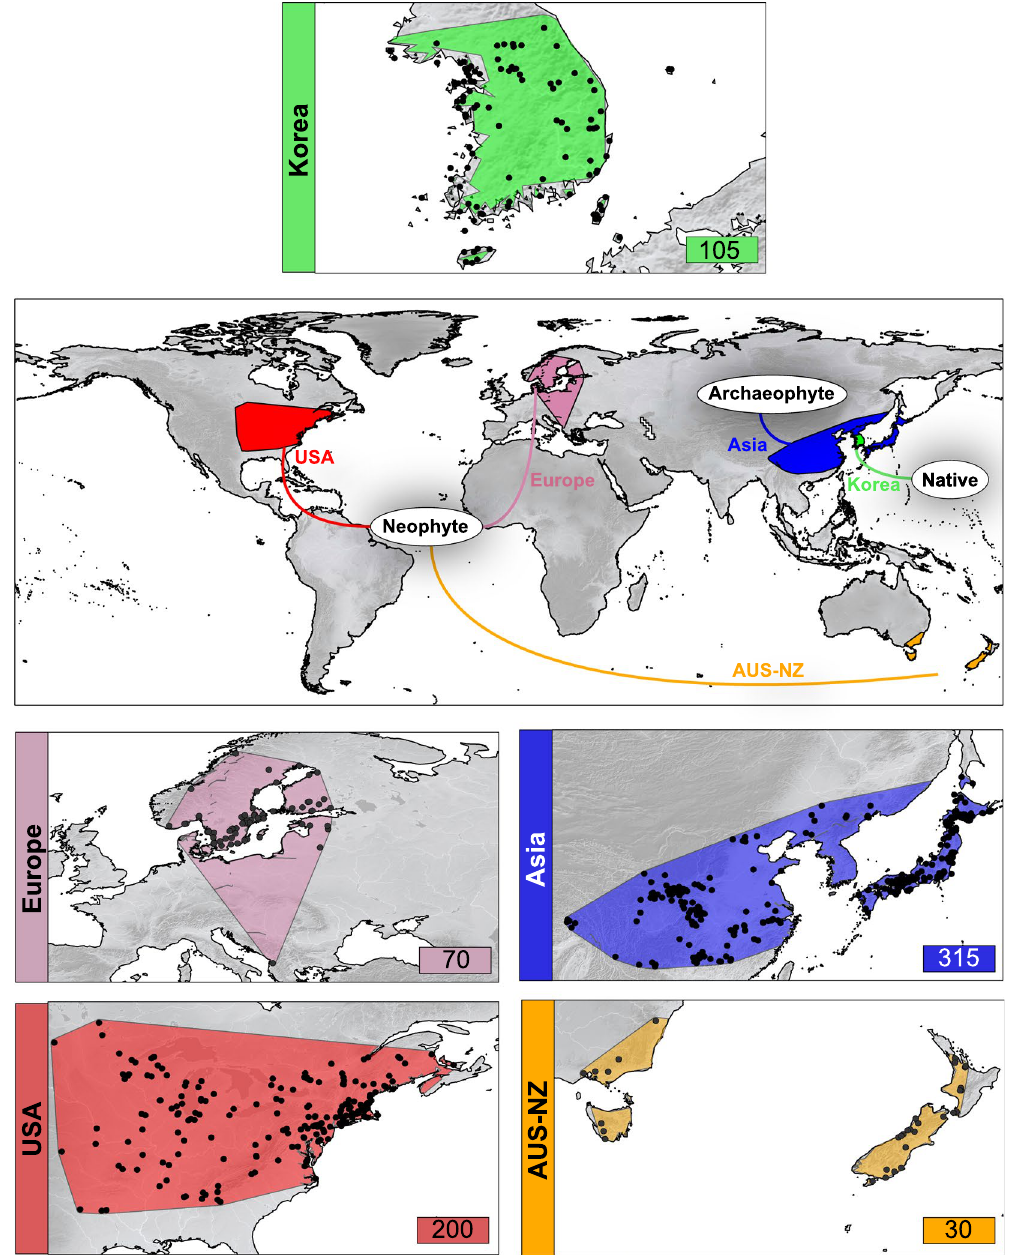
Figure 1. Global representation of distribution areas of Lilium lancifolium as native, archaeophyte, and neophyte. For each of the ranges, the occurrences are represented in black dots, and environmental background in its corresponding color is shaded. The number of total presence records used is also